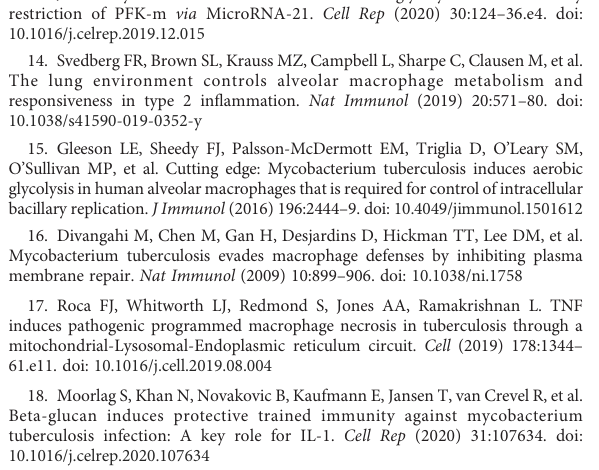
SUPPLEMENTARY TABLE 1 Differential expression statistics in RNA-Seq data from murine macrophages.